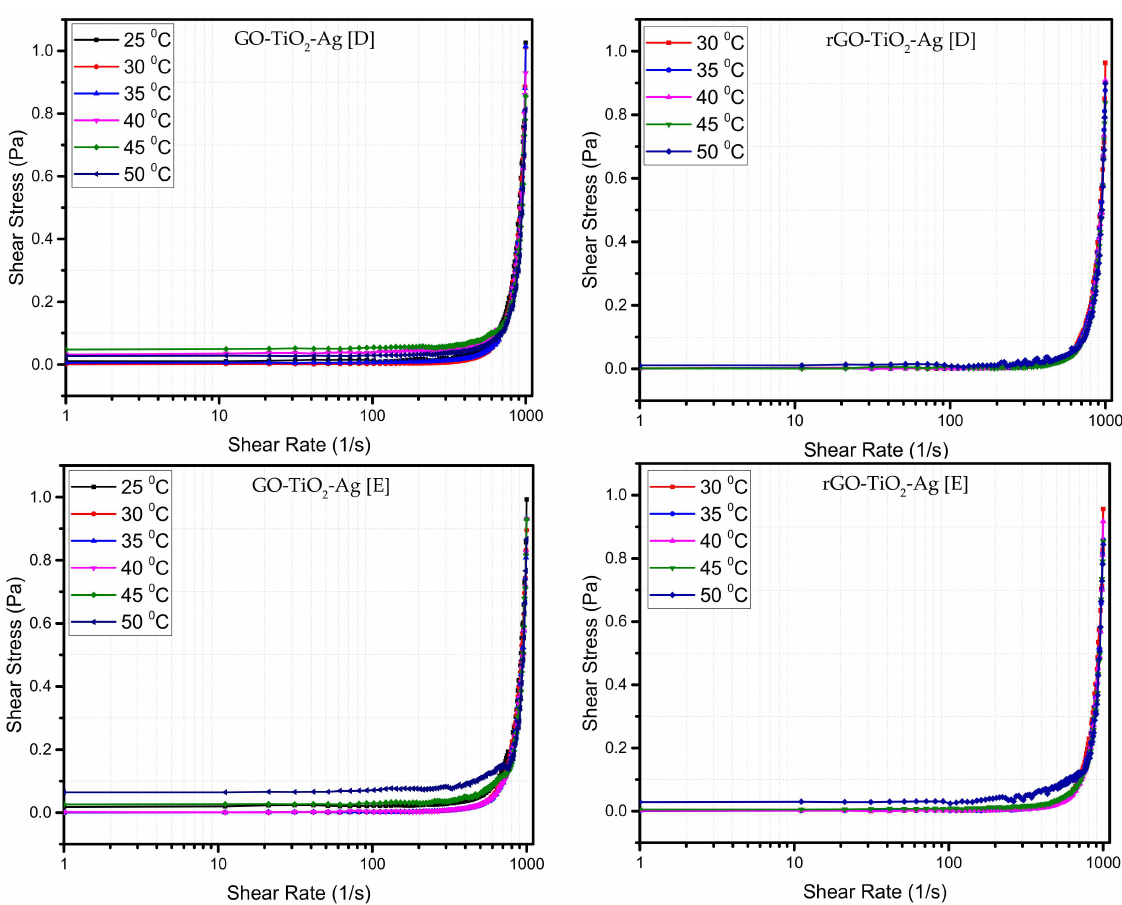
Figure 5. Shear stress vs. shear rate at different temperatures and concentrations of ternary hybrid nanoparticles. ( A – E ) are serial